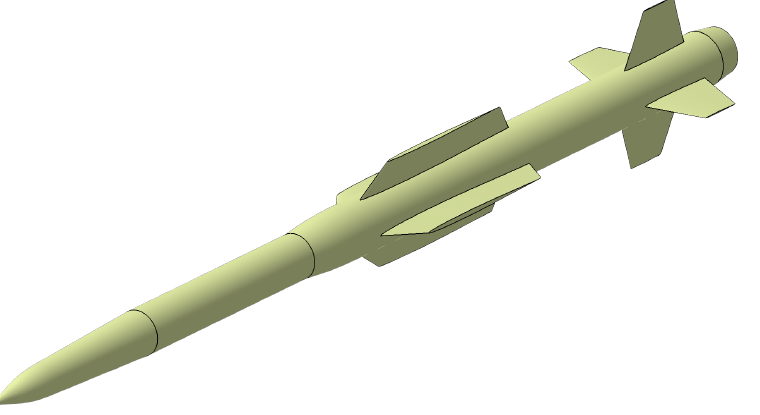
Figure 1. Model of interceptor.